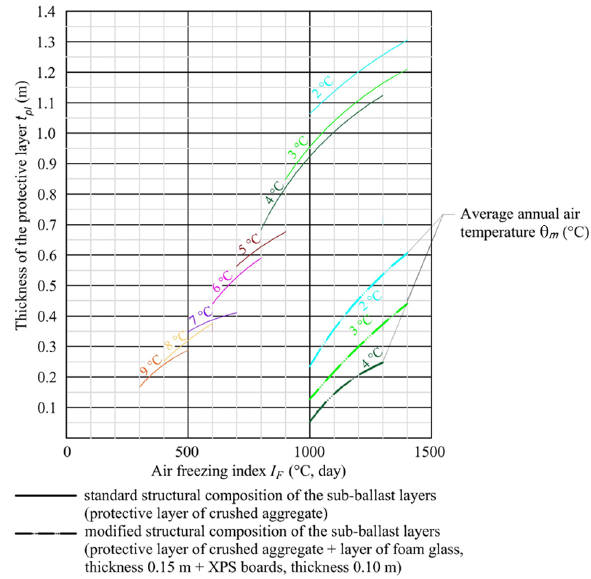
Figure 11. Design nomogram: dependence of the thickness of the crushed aggregate protection layer on different climatic conditions for standard and modified construction of the sub-ballast